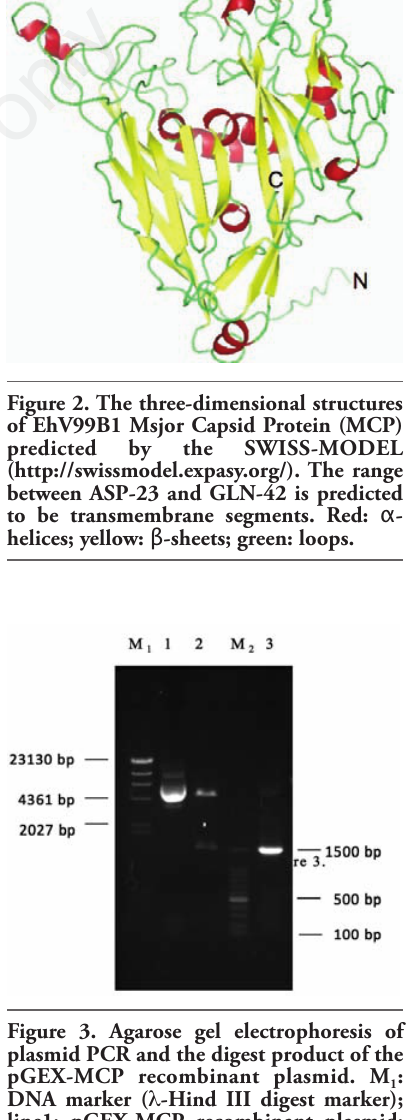
(AAL58857.1), EhV201 (AAL58858.1), EhV208 (AAL58853.1).